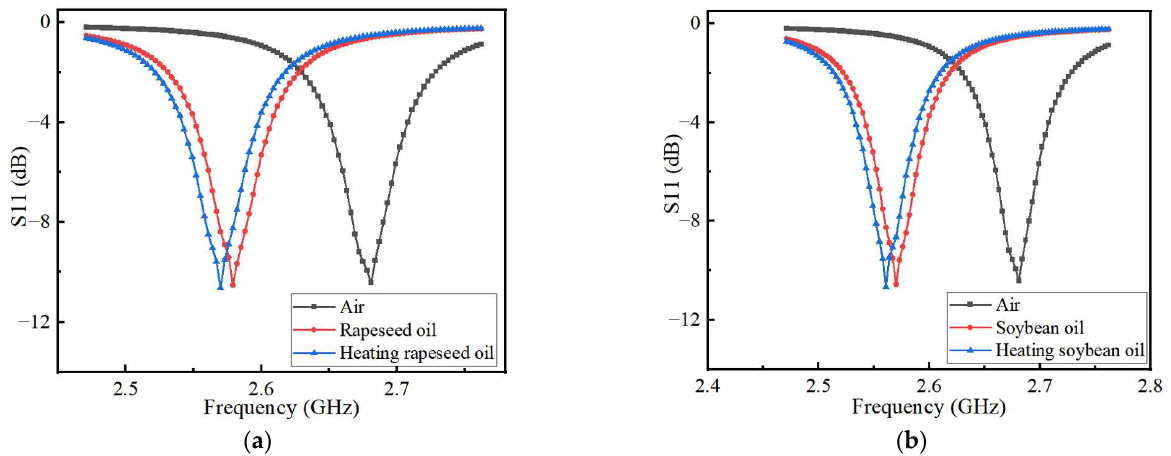
Figure 9. Simulation results of the effect of different ( a ) canola oil and ( b ) soybean oil cooking oil on the resonant frequency of the sensor before and after